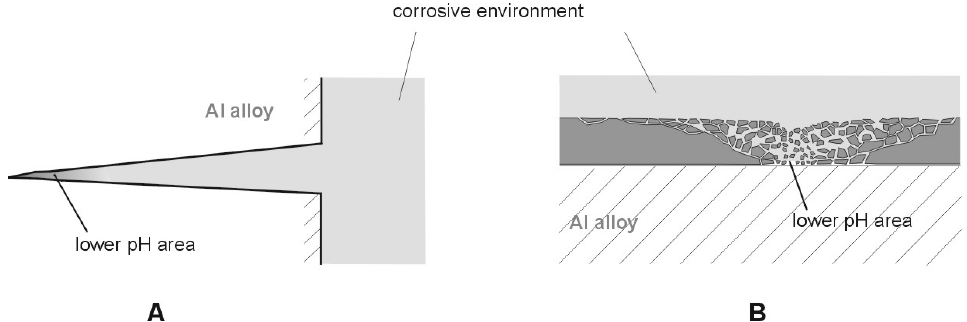
Figure 1. Spots corresponding to greater hydrogen concentrations i.e., lower pH. (Figures are not in scale.) ( A ) Stress corrosion cracking, ( B ) faults in protective coating.